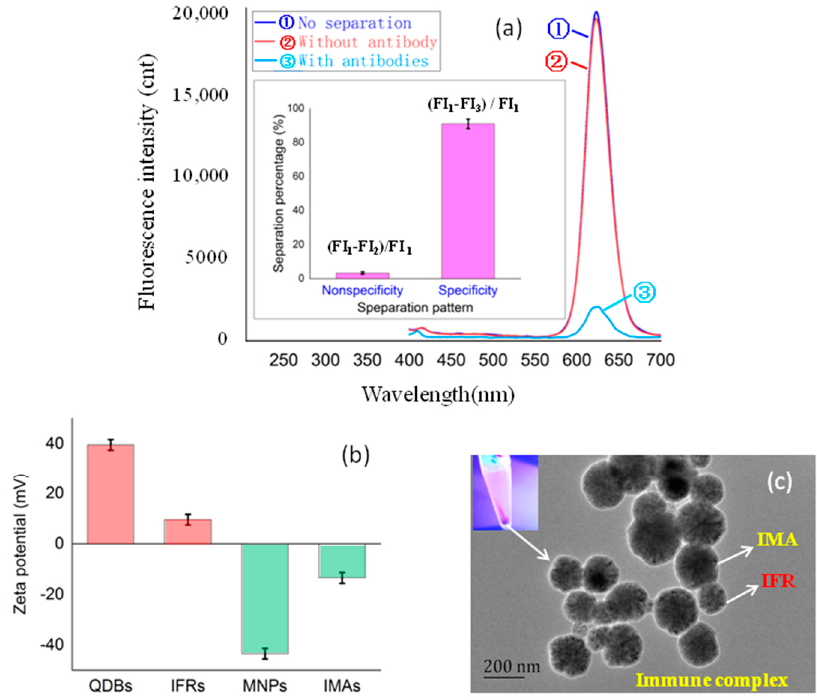
Figure 2. The evaluation of the performance of IFRs and IMAs. ( a ) The evaluation of specific/nonspecific binding between IFRs and IMAs. ( b ) The Zeta potentials of IFRs and IMAs. ( c ) The TEM of separated immune complex of IFRs (100 nm) and IMAs (200 nm).